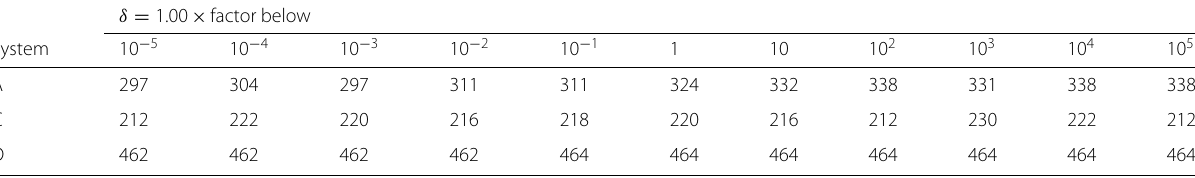
Table 2 Number of consecutive iterations yielding realistic behavior for Systems A, C and D at different values of δ δ = 1.00 × factor